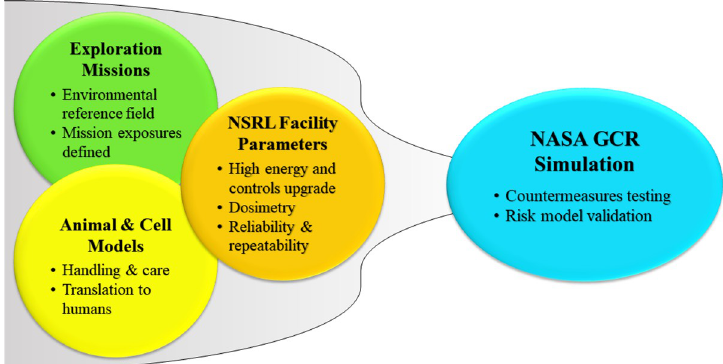
Fig 1. Three key areas that must be developed together to ultimately provide the GCR simulator at NSRL. Development focused on establishing irradiation requirements and balancing facility capabilities and limitations, including constraints imposed by animal and cellular model systems. GCR, galactic cosmic radiation; NSRL, NASA Space Radiation